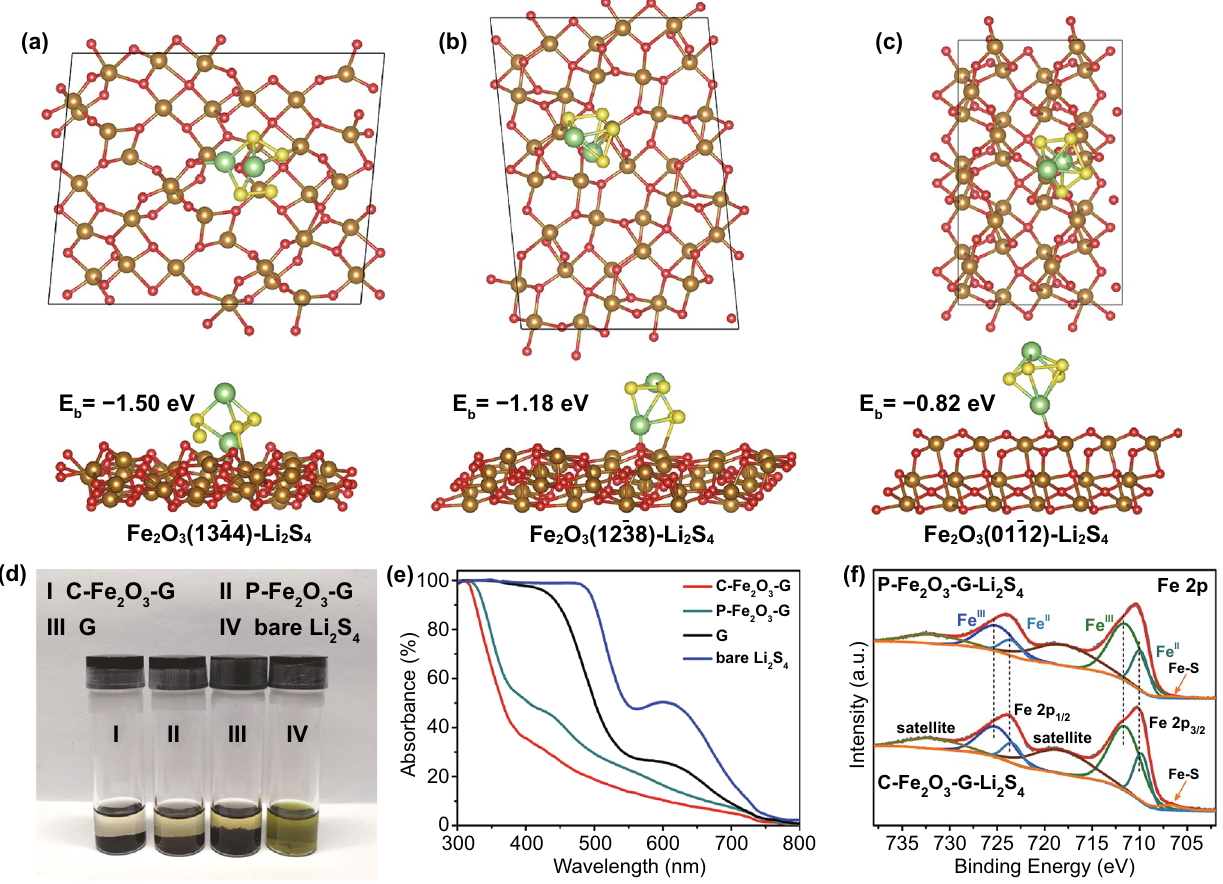
Fig. 2 a – c Optimized geometries of Li 2 S 4 adsorbed on different Fe 2 O 3 crystal facets. d Optical photograph and e UV–Vis spectrums of a bare Li 2 S 4 solution and the Li 2 S 4 solutions with different materials after static adsorption for 5 h. f Fe 2p XPS comparative analysis of C-Fe 2 O 3 -G and P-Fe 2 O 3 -G after interacting with Li 2 S